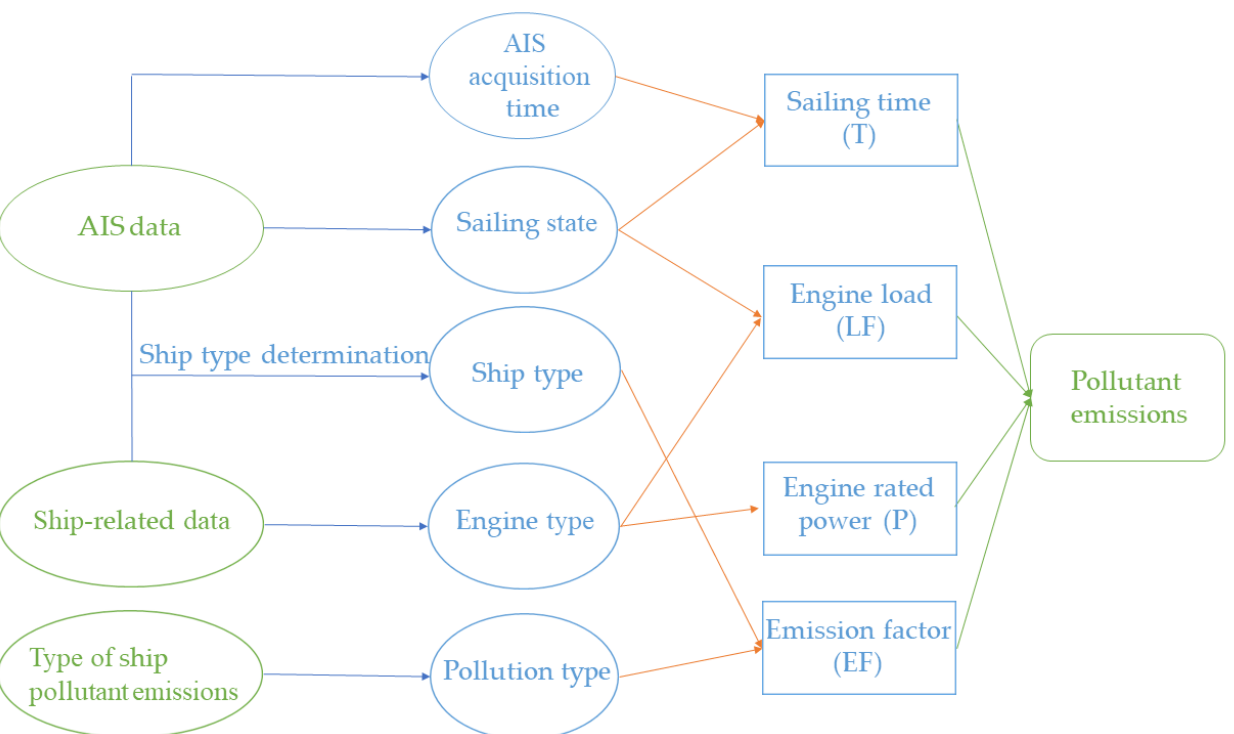
Figure 4. Calculation idea of ship pollutant emissions by the dynamic method.